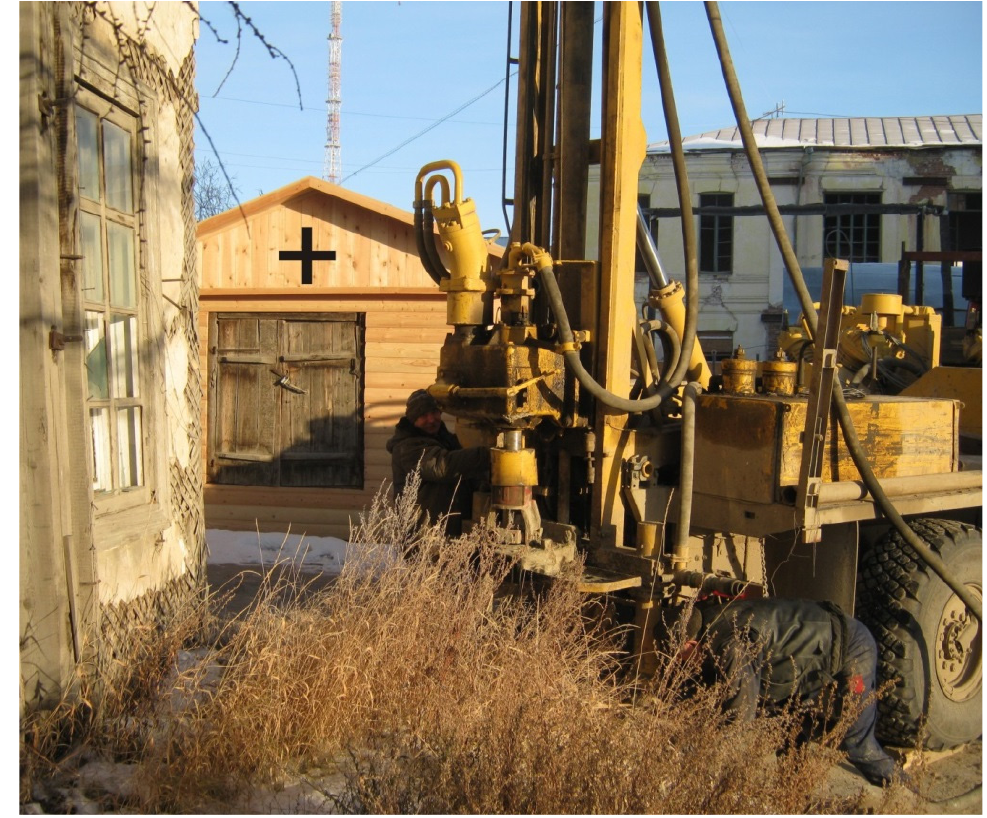
Figure 2. View of the Shergin Shaft’s superstructure (cross) and drilling of borehole #60. A somewhat different stratigraphy was obtained by the present authors based on the core from borehole #60 (Figure 3). The borehole was drilled by the Melnikov Permafrost Institute in October 2010 in the immediate vicinity of the Shergin Shaft. The subsurface conditions determined from the borehole core are presented in Table